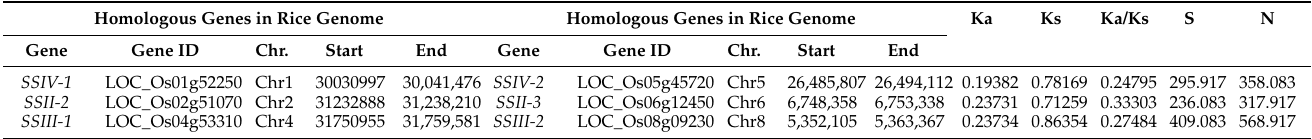
Figure 4. Synteny analysis of SS genes in the rice genome. Each rice chromosome is displayed in a different color. Duplicated gene pairs are displayed and linked using lines with that color. Table 3. Synteny analysis for the starch synthase gene family in the rice